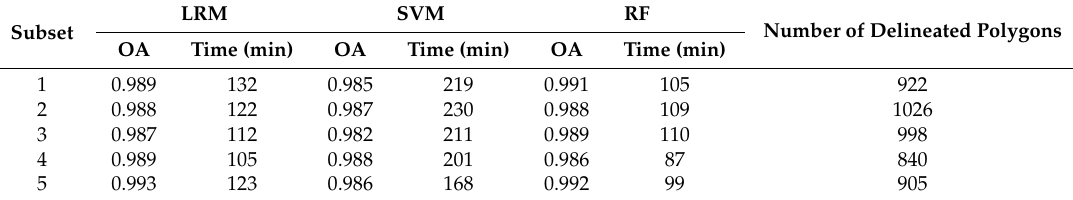
Table 3. Summary of the pretesting using the five subsets. For the three classifiers Logistic Regression Model (LRM), Support Vector Machine (SVM), and Random Forest (RF), the obtained overall accuracies (OA), computing time in minutes, and the number of delineated polygons are given. The models were 10-fold cross-validated.